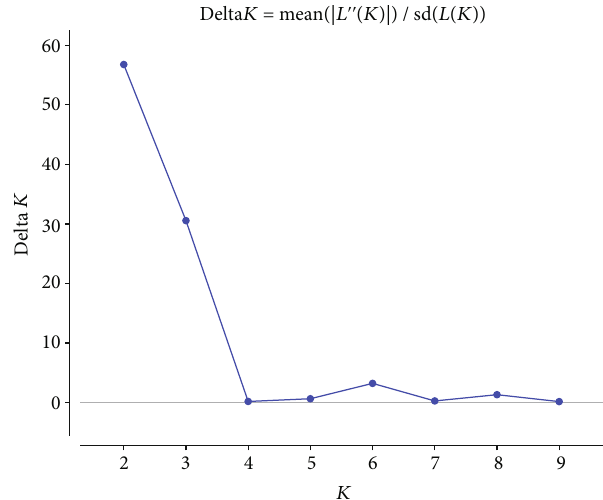
Figure 3: Structure estimation of the number of subgroups for K ranging from 1 to 10.